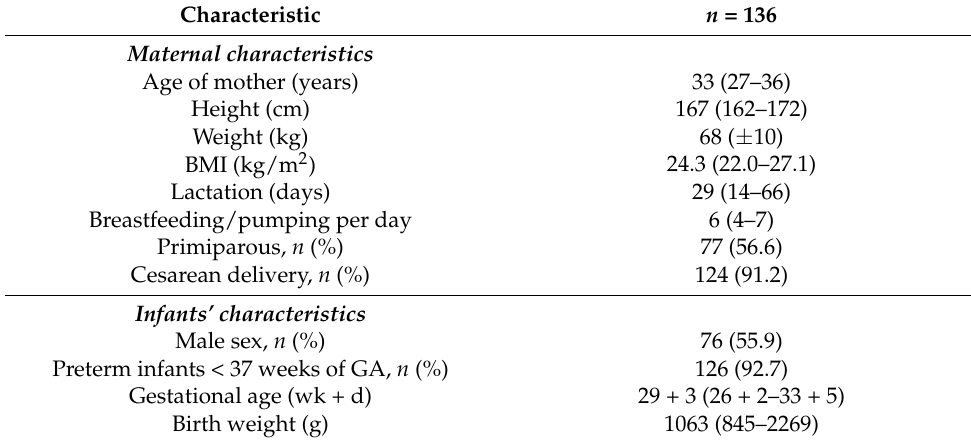
Table 1. Mothers’ and infants’